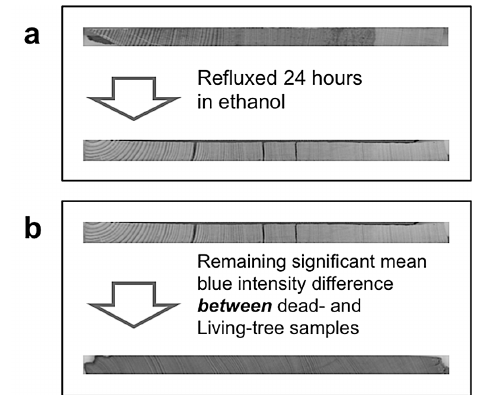
Fig. 1. (a) Sample photos of living-tree samples before and after al- cohol soxhlet extraction. This shows a stark contrast in blue inten- sity between untreated and refluxed samples. (b) Example of two cores, one living tree sample and one log sample, the latter died around 1650. This also shows a stark contrast between dead-tree samples and living-tree samples suggesting that dead-tree samples are more permanently discoloured than living-tree samples. The red and green colour spectrum is filtered out of the photos, leaving only the blue spectrum that is represented in greyscale. Fig. 2. Schematic figure of different tree-ring parameters to show